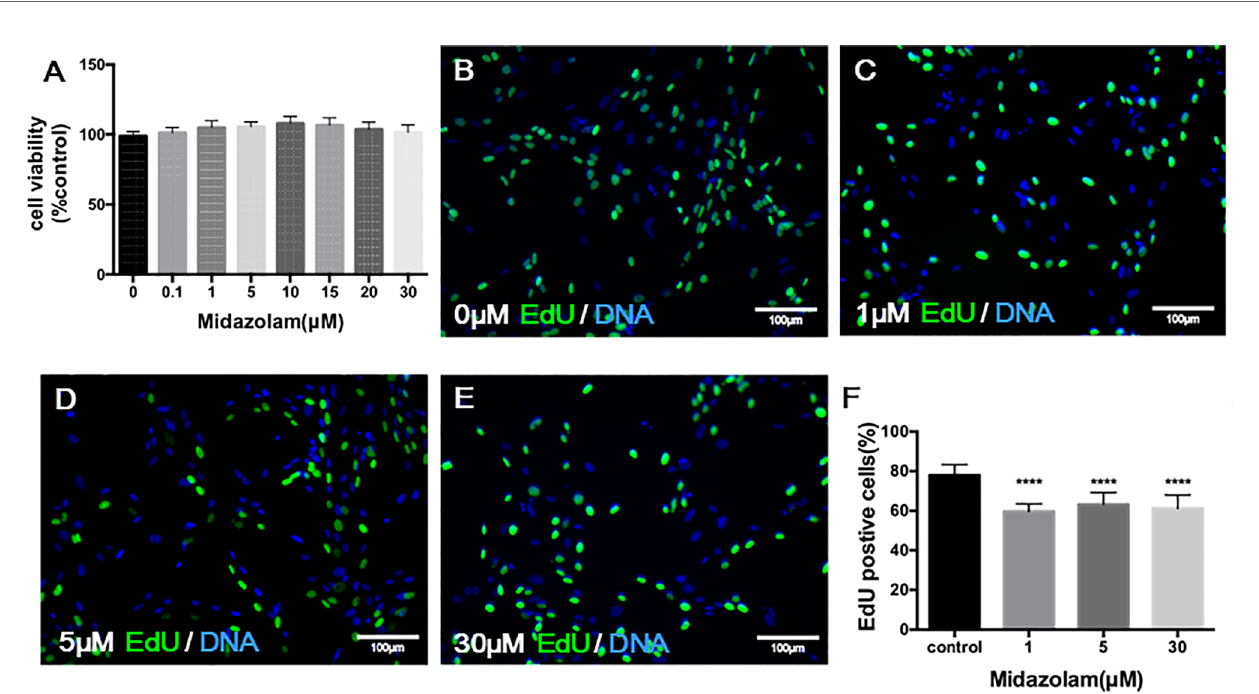
FIGURE 3 | Effects of midazolam on the viability (A) and proliferation (B – F) of stem Leydig cells (SLCs): (A) SLCs were incubated with midazolam for 24 h by the end of the expanding period, and a tetrazolium compound was added to the culture during the last 3 h. The formazan product formed by living cells was quali fi ed by absorbance at 490 nm. (B – F) SLCs were incubated with different concentrations of midazolam (B) , 0 m M; (C) , 1 m M; (D) , 5 m M; and (E) , 30 m M) for 48 h by the end of the expanding period; during the last 24 h, the cells were labelled by EdU. Nuclei of the dividing cells were stained in green, and all cell nuclei were stained in blue (4 ′ ,6-diamidino-2-phenylindole dihydrochloride (DAPI)). (F) Quanti fi cation of EdU-labeled cells as % of total cells. Data were expressed as mean ± SEM of four experiments. Signi fi cantly different from the control group at ****p <